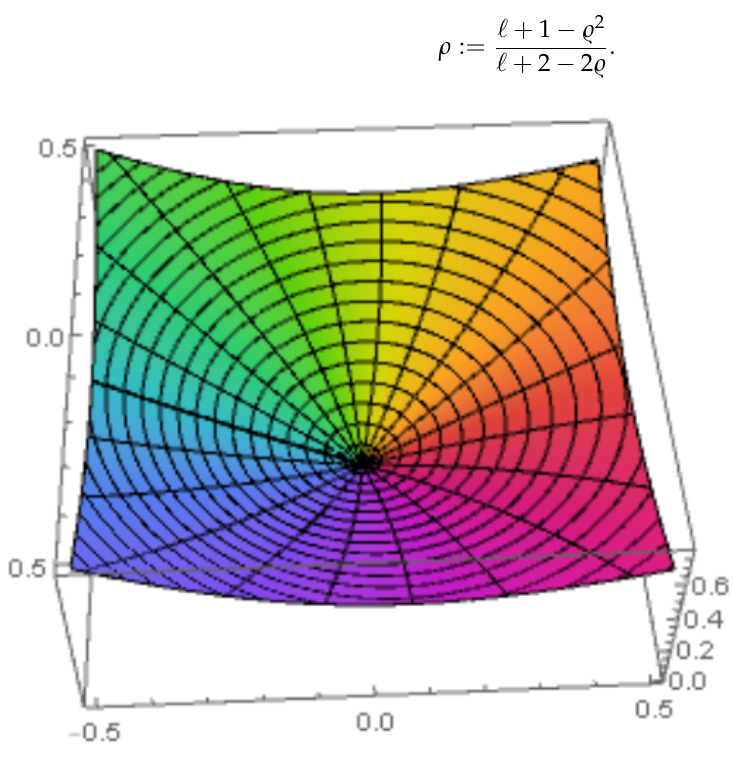
Figure 2. 3D–Plot of the maximum function of starlikeness for (cid:36) =